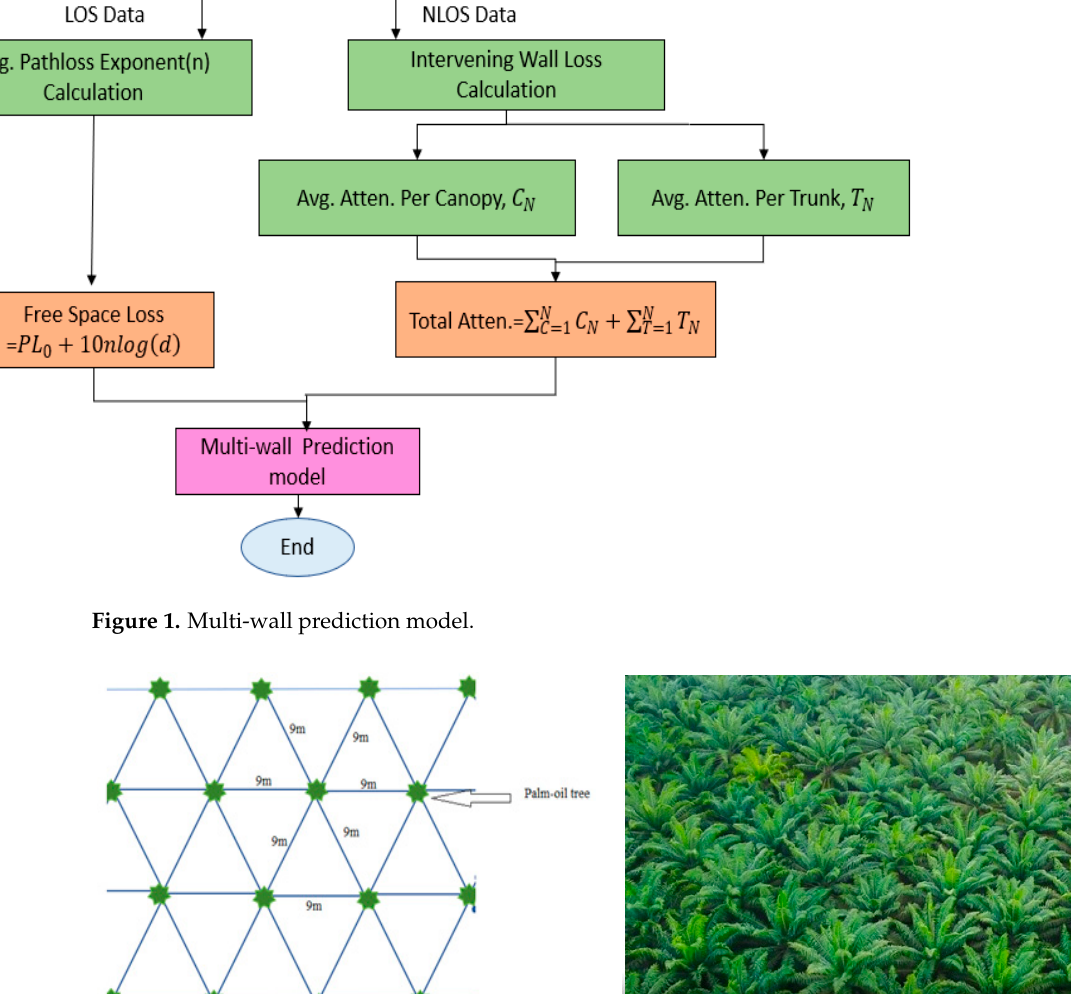
Figure 2. Palm oil planation pattern ( left ); palm oil plantation top view ( right ).